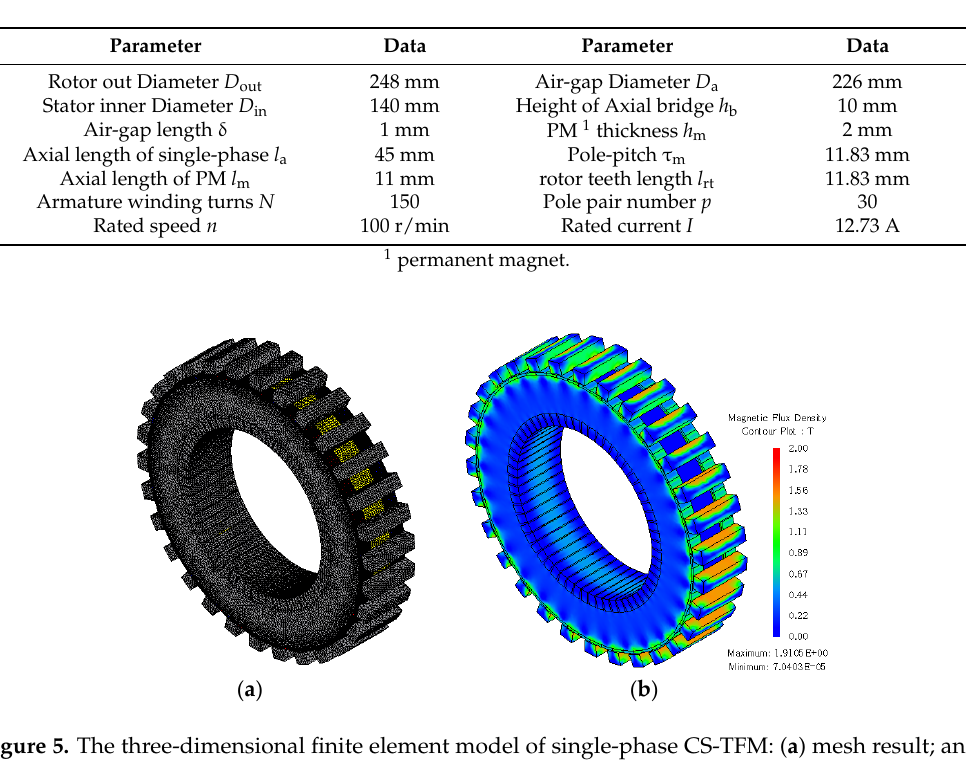
Table 1. The main design parameters of stator core transverse flux motor (CS-TFM).